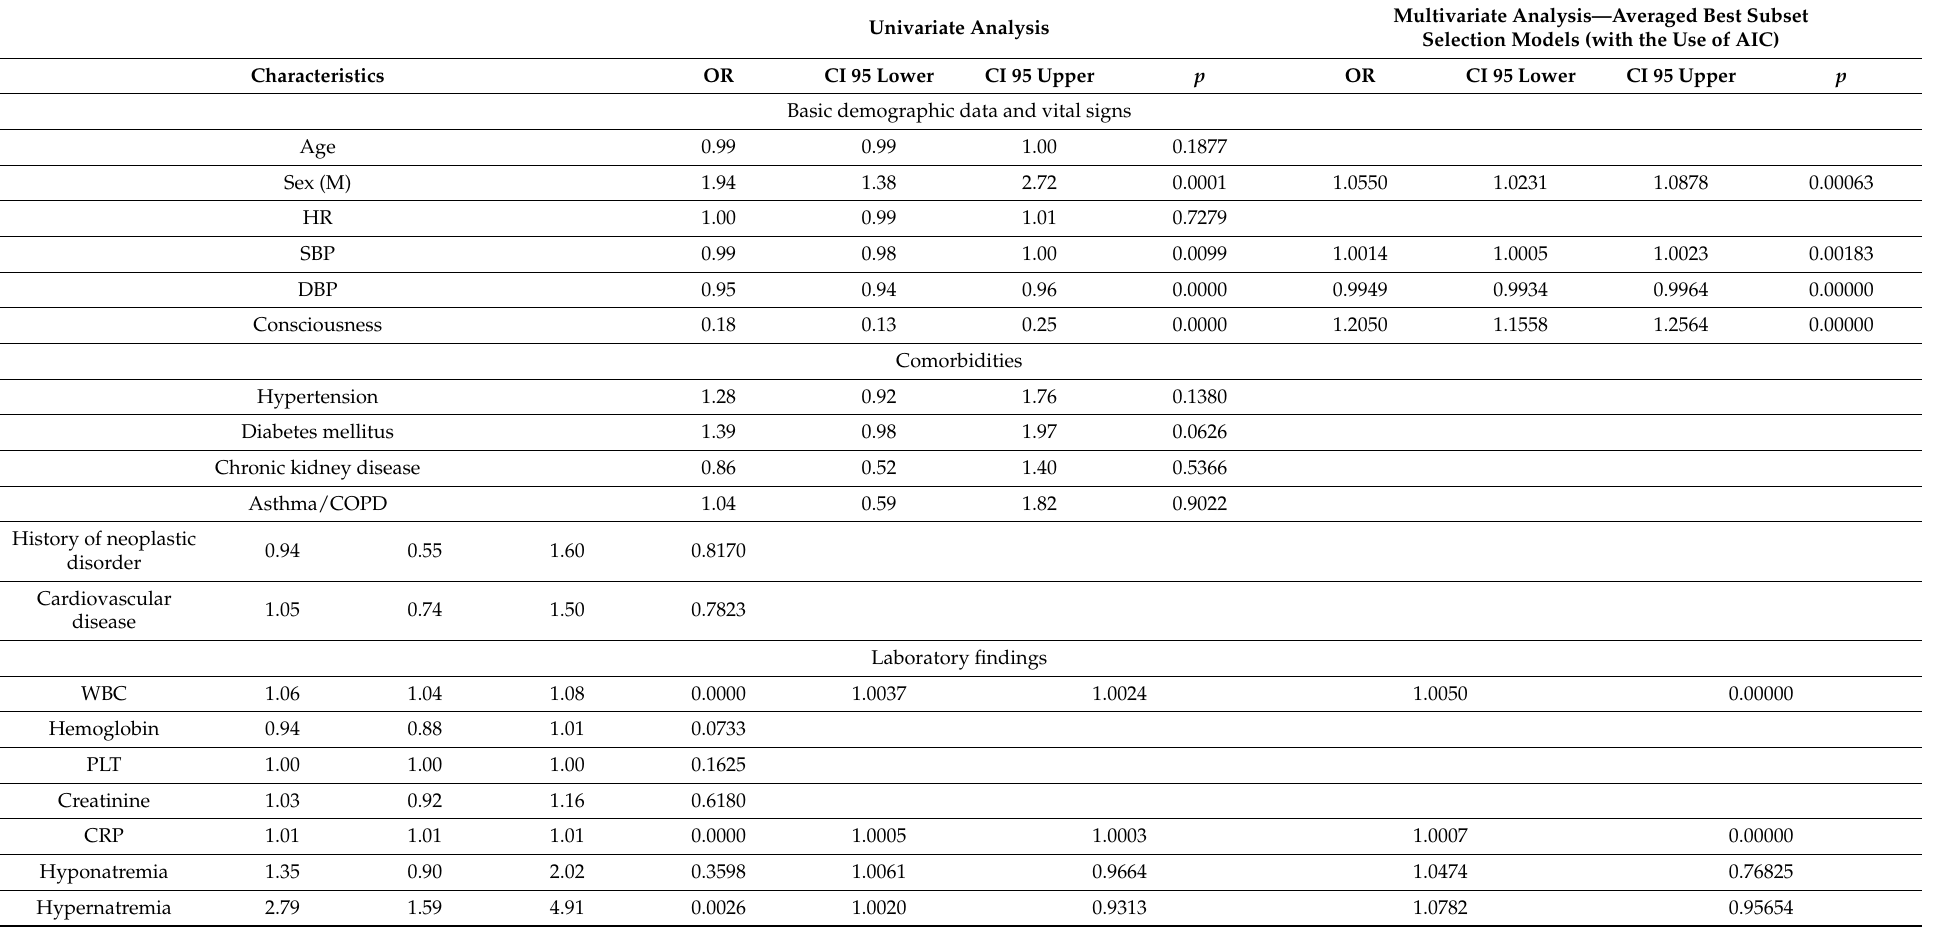
Table 3. Results of the univariate and multivariate analysis of ICU admission predictors in COVID-19 patients.